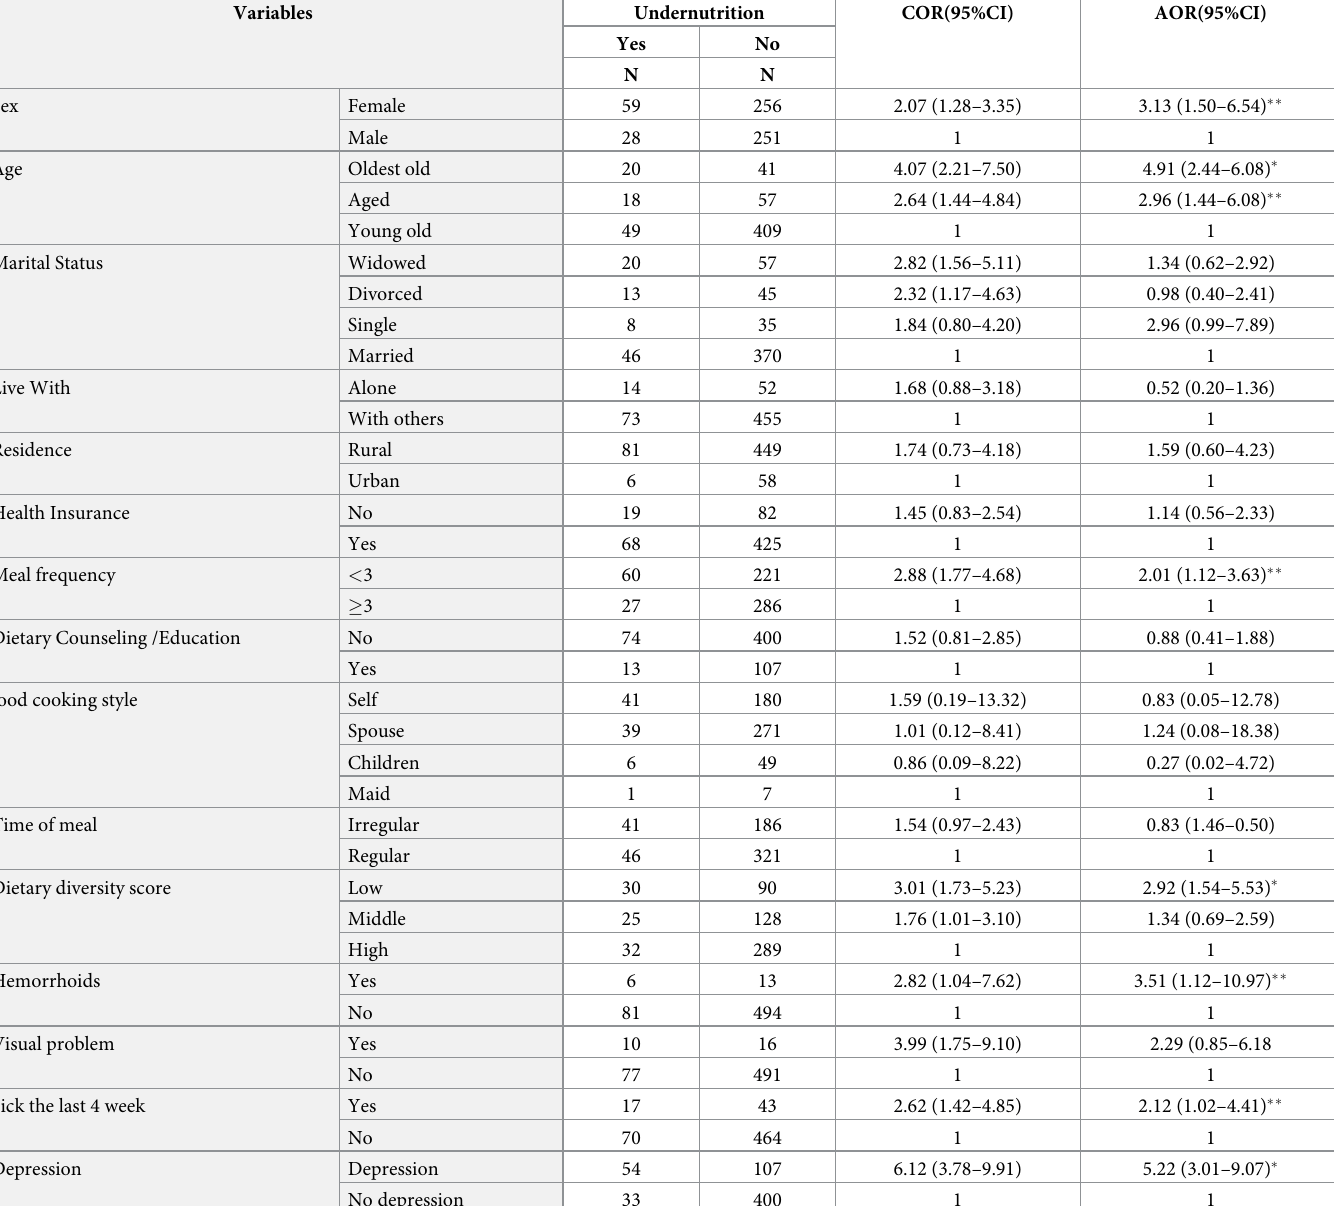
Table 3. Bivariable and multivariable logistic regression of factors associated with undernutrition among the older adults in Womberma district, North West, Ethi- opia, 2020 (n = 594).